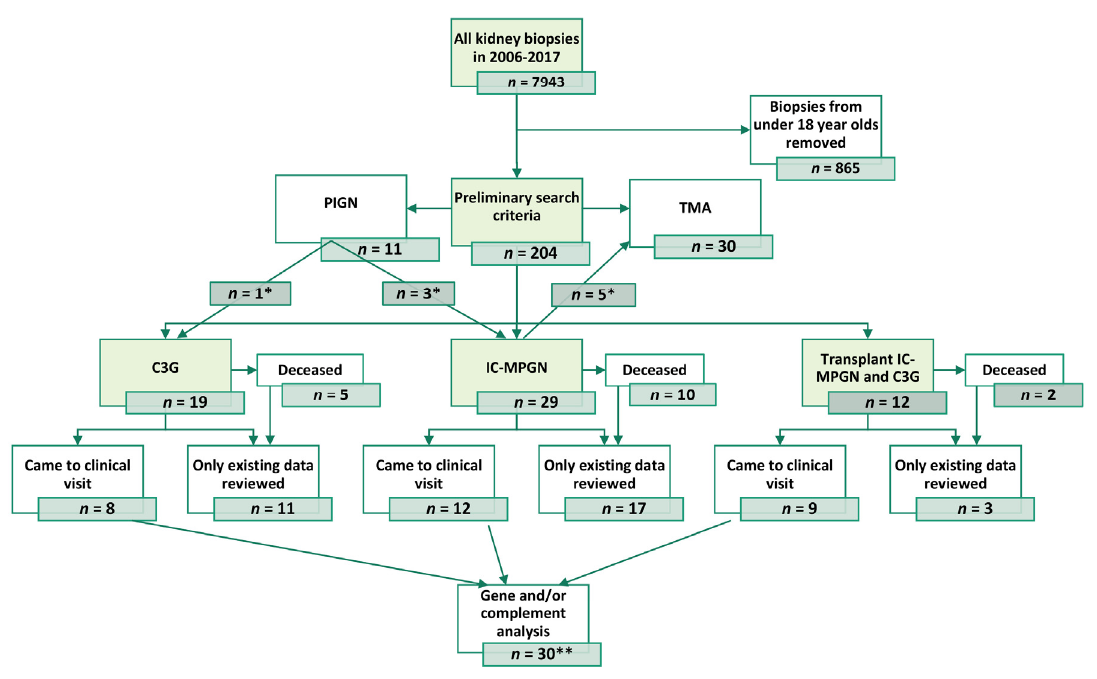
Figure 1. Study flow of the research patients. * After index biopsy re-evaluation, patients were reassigned to an accurate diagnostic category, ** For one C3G patient complement analysis sample was acquired before research visit and included in complement analysis (total n = 30). PIGN = postinfectious glomerulonephritis, TMA = thrombotic microangiopathy, C3G = C3 glomerulopathy, IC-MPGN = immune-complex-mediated glomerulonephritis.